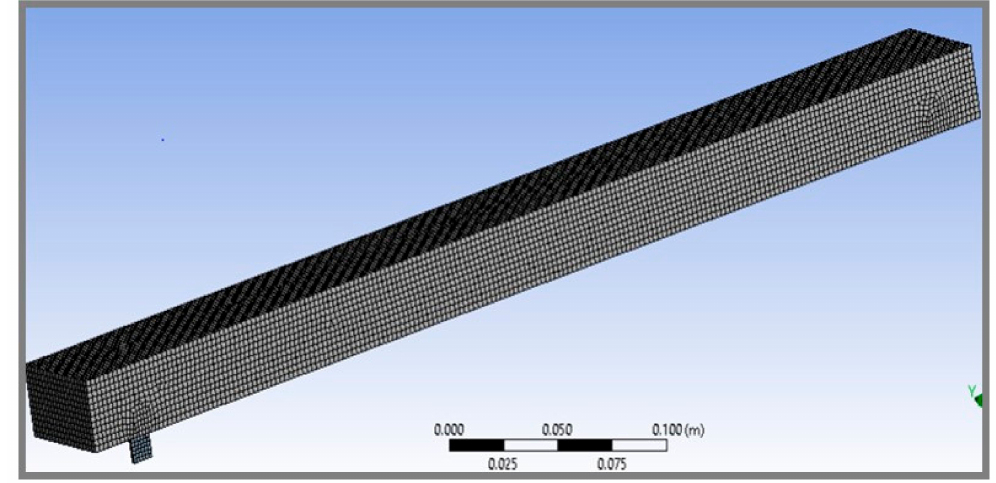
Figure 4. Hexa-dominant finite volume (FV) mesh across the 3D domain; a total of 49,614 elements